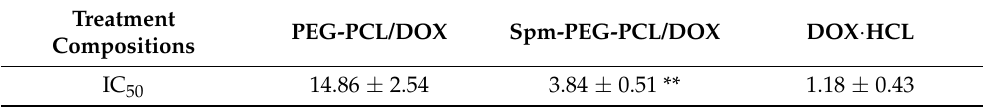
Figure 6. Cytotoxicity of blank and drug-loaded micelles in A549 cells ( n = 3). ( A ) Cytotoxicity of blank Spm-PEG-PCL micelles at varying polymer concentrations. ( B ) Cytotoxicity of Spm-PEG-PCL/DOX, PEG-PCL/DOX micelles and DOX · HCL. Table 3. IC 50 values of different preparations (mean ± standard deviation, n = 3).